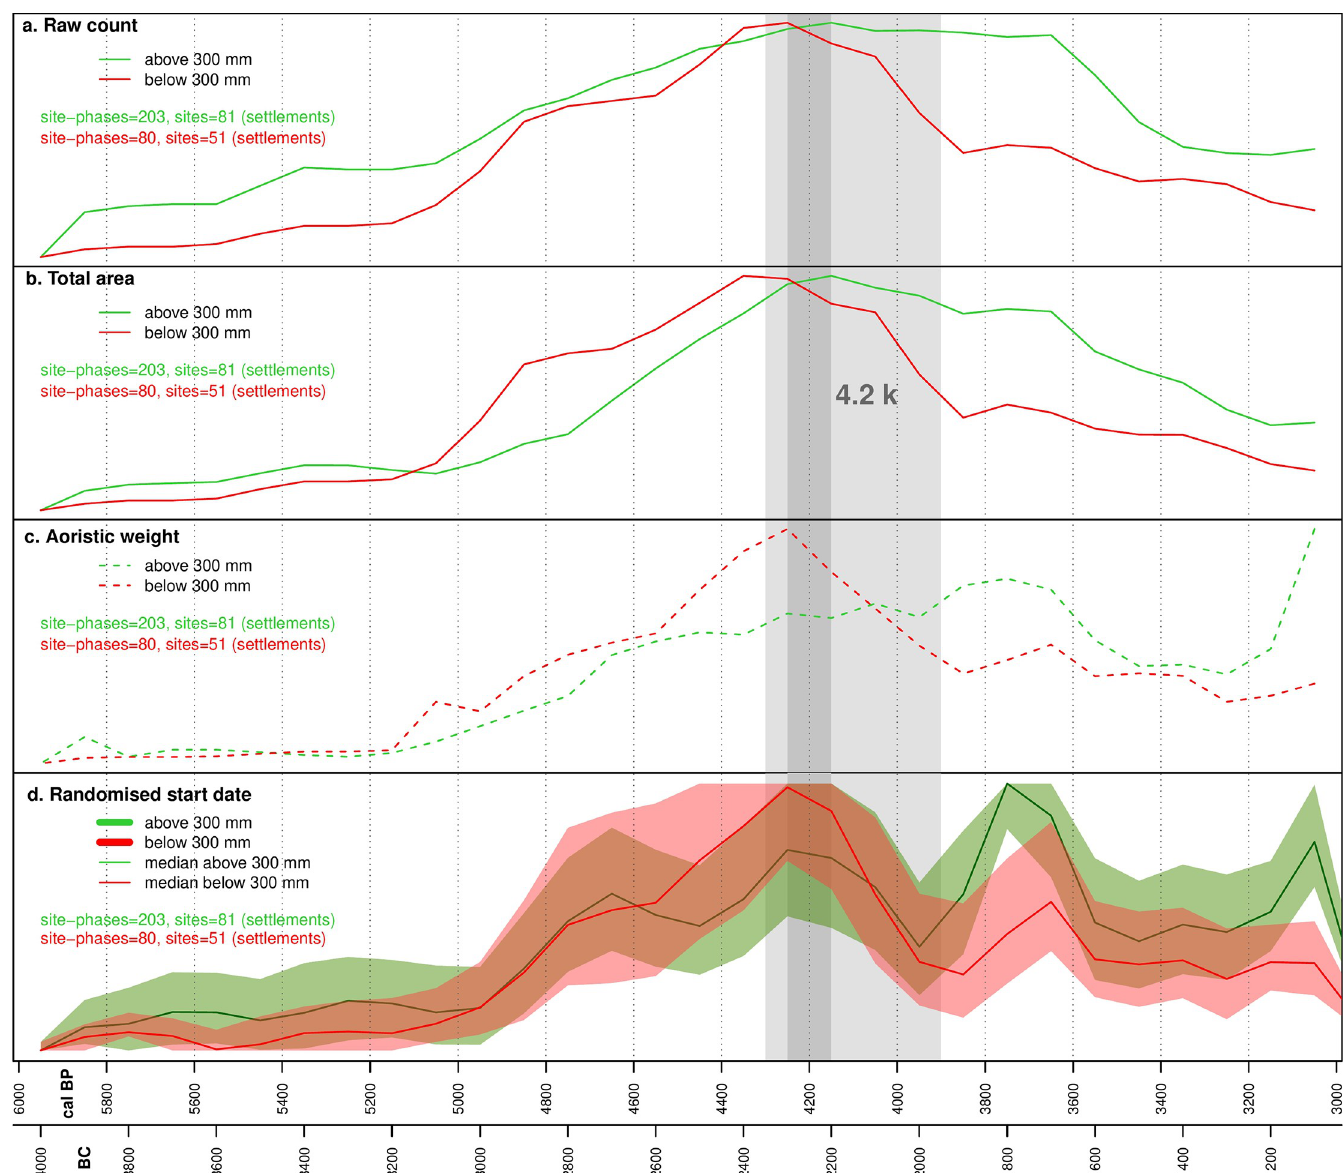
Fig 5. Urban settlements dataset trends. a: Raw site counts. b: Total area (summed). c: Aoristic weight (of counts). d: Randomized start dates (of counts).